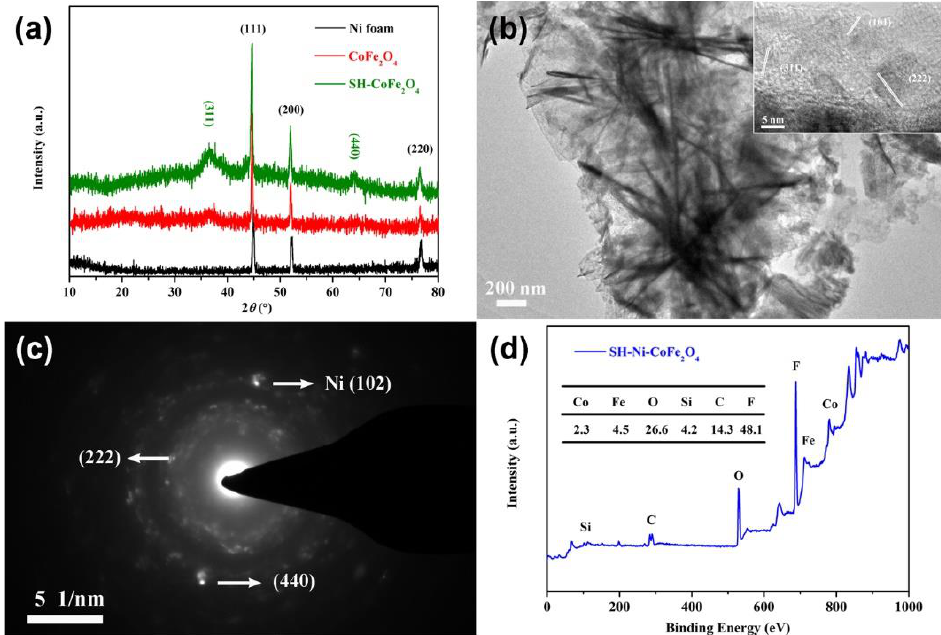
Nanomaterials 2022 , 12 , x FOR PEER REVIEW 5 of 7 Figure 2. XRD analysis of CoFe 2 O 4 composite materials ( a ). TEM morphology ( b ) and structure ( c ) analysis of CoFe 2 O 4 . XPS analysis ( d ) of superhydrophobic Ni-CoFe 2 O 4 . Further fine spectral analyses of Co and Fe revealed that CoFe 2 O 4 had a mixed valent state consisting of Co 2+ , Co 3+ , Fe 2+ and Fe 3+ (Figure 3a,b). Relevant information of the de- convolution is presented in Table S1. The superhydrophobic Ni-CoFe 2 O 4 foam exhibited